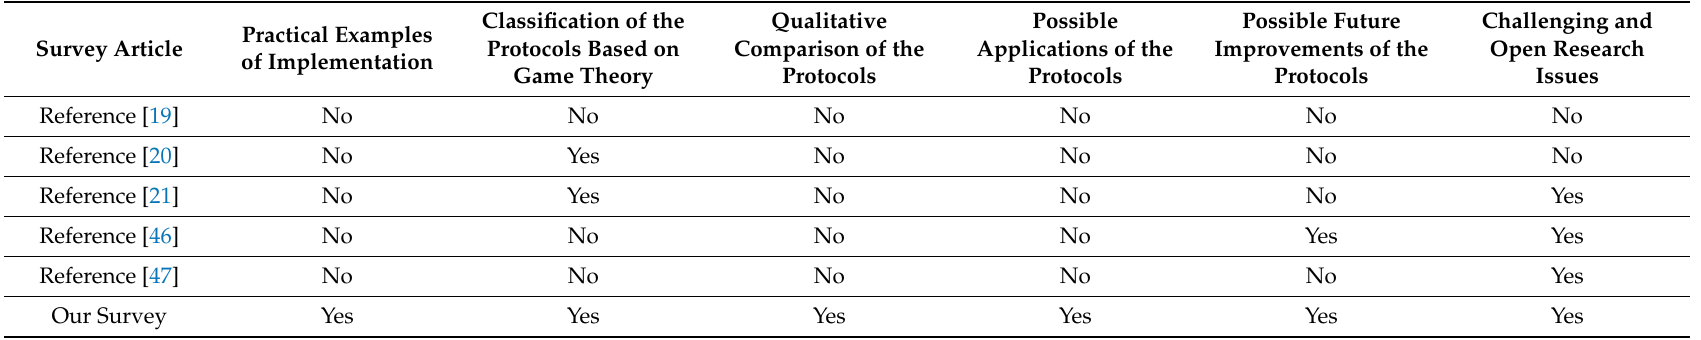
Table 2. Comparison of our survey with existing